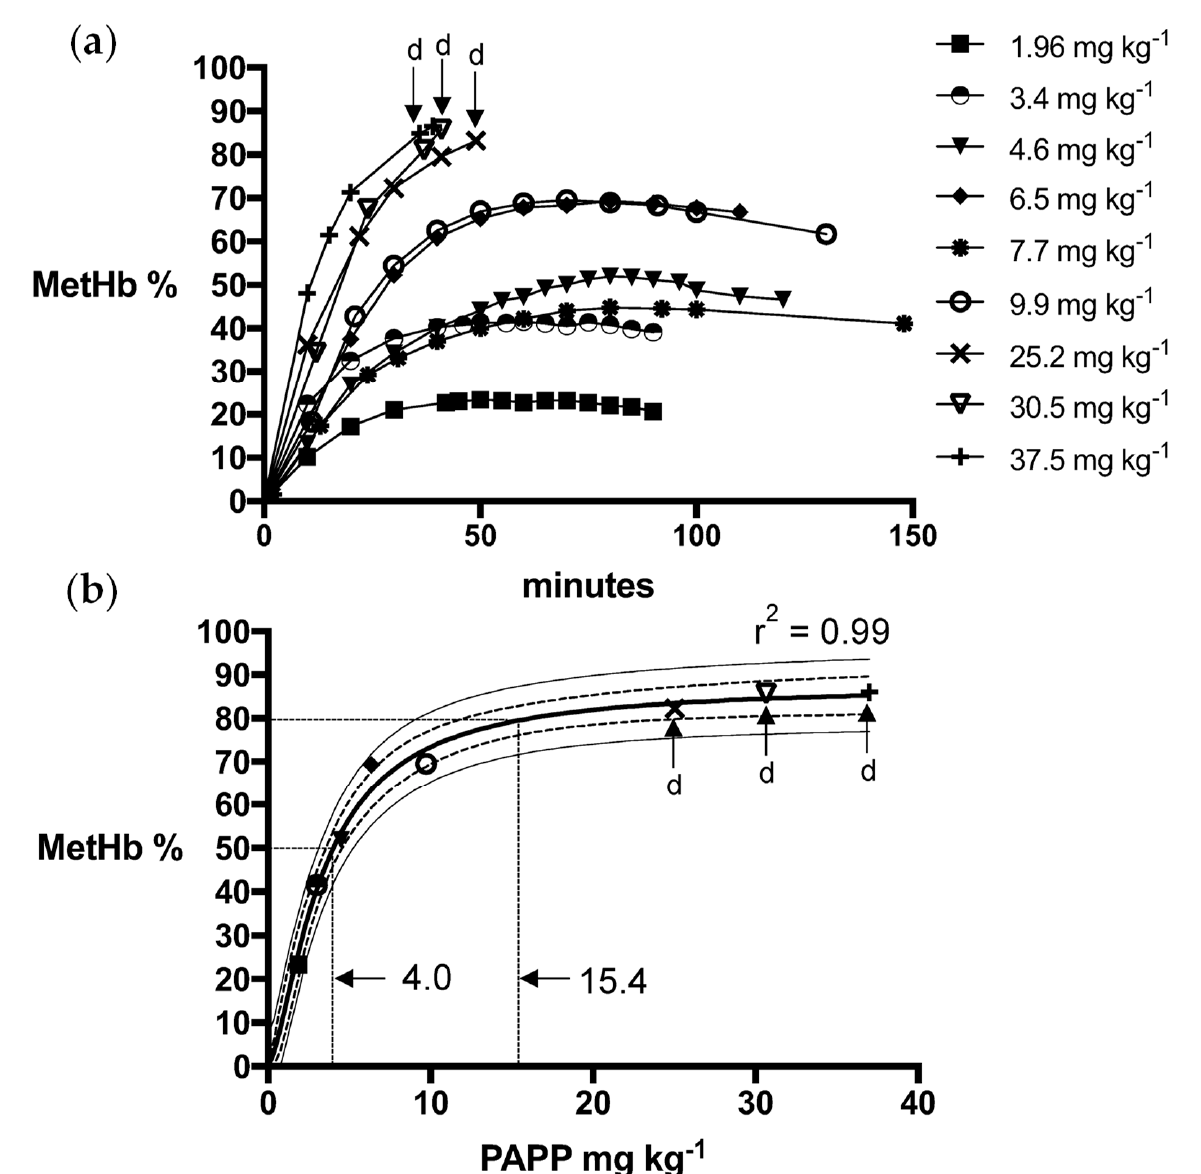
Figure 1. ( a ) Methaemoglobin (MetHb %) response relative to oral dose of PAPP + DMSO in foxes and ( b ) the fitted logistics dose-response model for peak MetHb % with 95% confidence (dashed line) and prediction interval (solid line) and whether death (d) resulted.